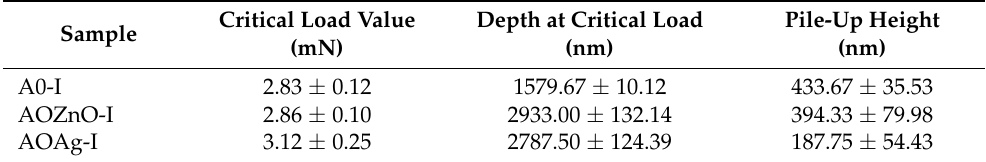
Table 3. Load and depth values at which fracture occurs as well as the obtained values for pile-up which appeared after the scratch tests. Results are expressed as mean ± standard deviation, n =